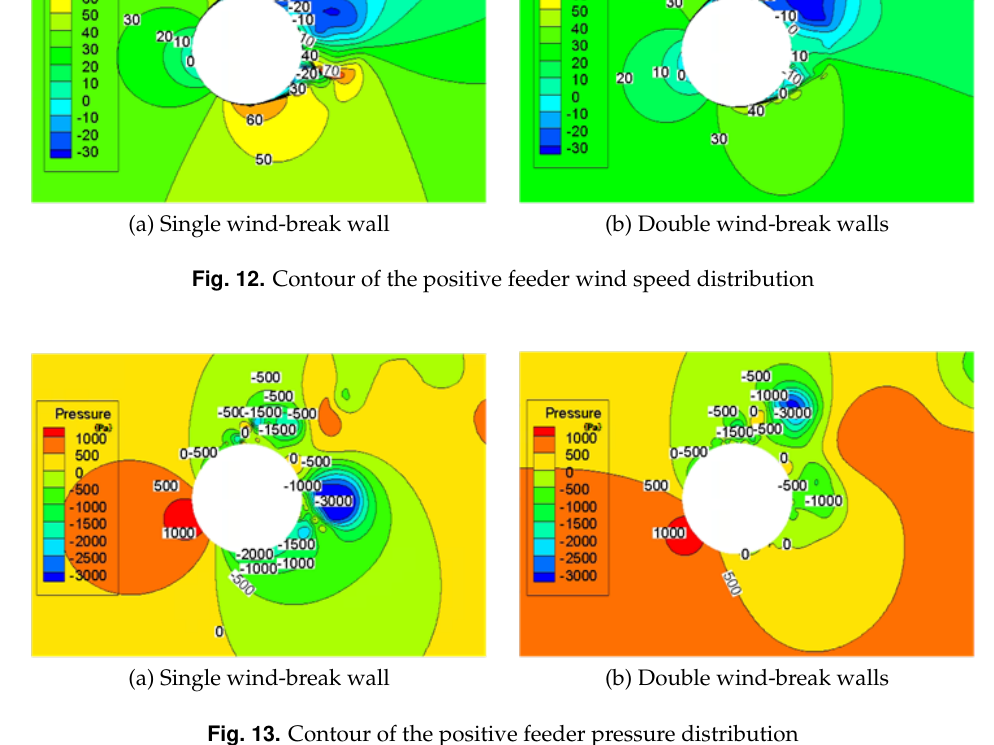
Fig. 13. Contour of the positive feeder pressure